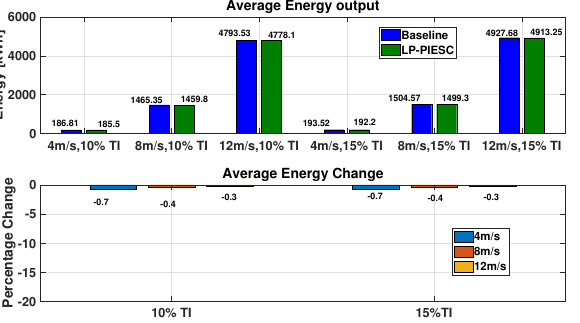
Figure 11. Energy capture comparison: Baseline vs. LP-PIESC. Average energy output with baseline optimal torque gain and LP-PIESC ( top ), percentage change in energy capture ( bottom ).